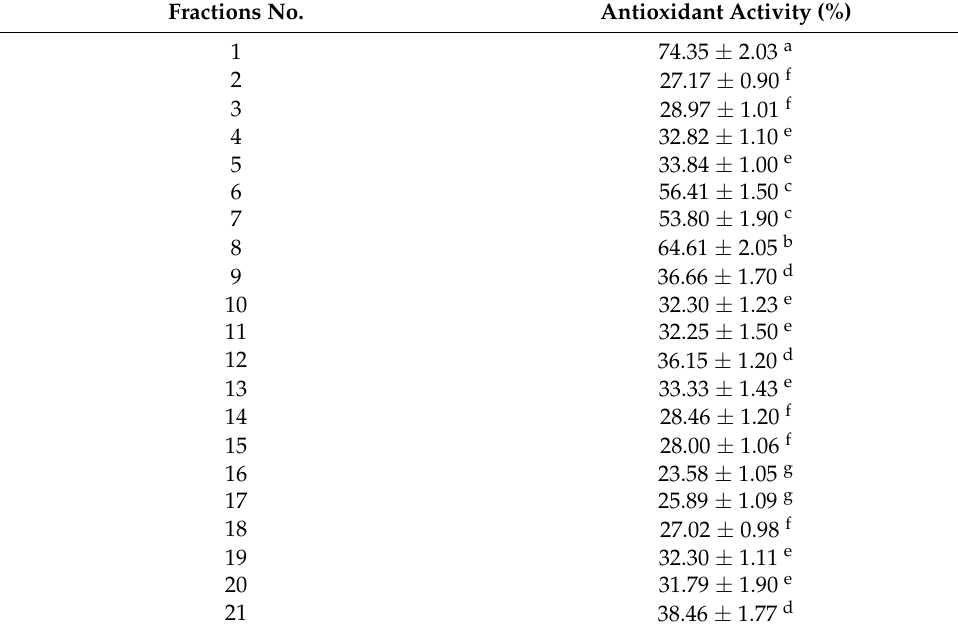
Table 12. Antioxidant activity (%) against ABTS assay of 21 fractions of the potential extract (0.44 mg/L Zn) of Nostoc linckia at 200 ppm. Fractions